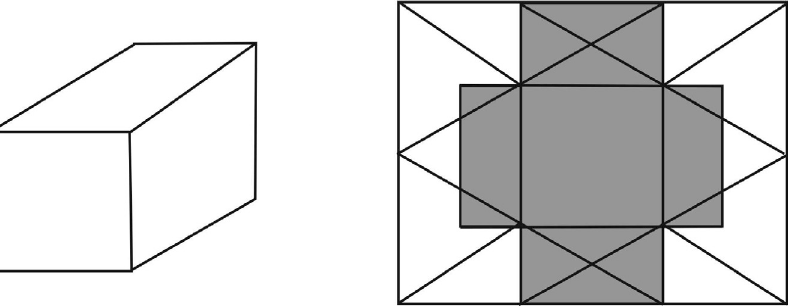
Figure 3. Example of an embedded figures test. Participants are asked to identify the figure on the left within the figure on the